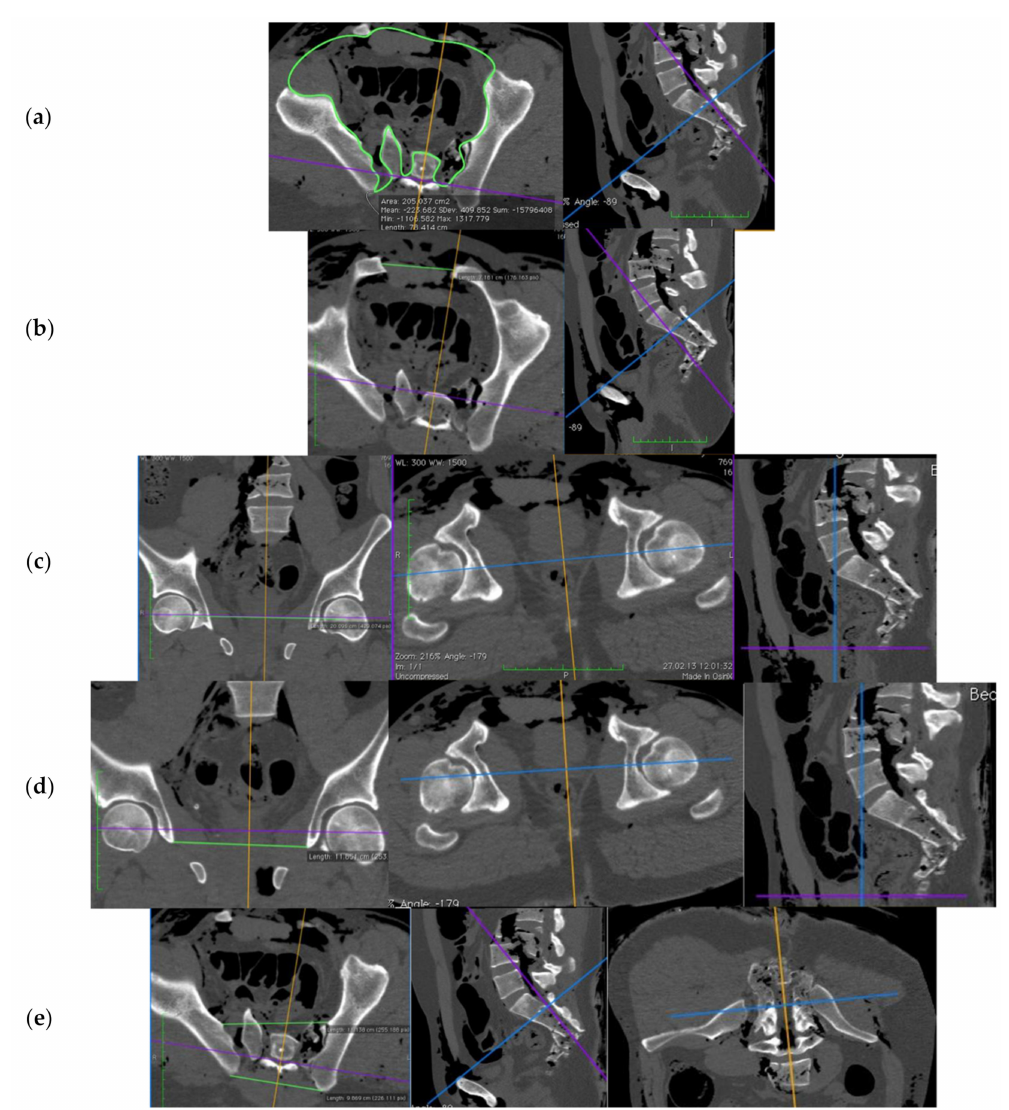
Figure 2. Representation of the different measurement planes and distances using OsiriX ® : ( a ) pelvic entrance plane; ( b ) symphyseal width; ( c ) femoral head distance; ( d ) distance of Köhler’s tear figures; ( e ) ventral and dorsal distance between sacroiliac joints (source: Haussmann [22],